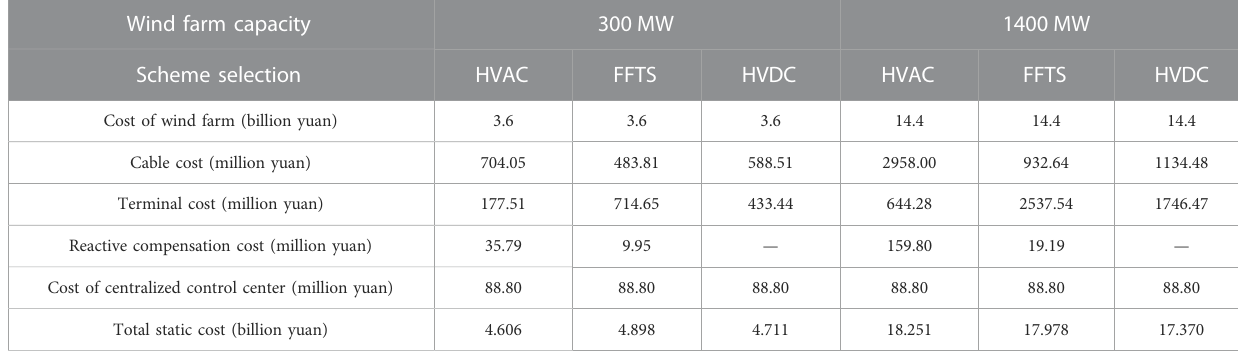
TABLE 3 Static cost analysis at 80 km transmission distance at 300MW and 1400 MW